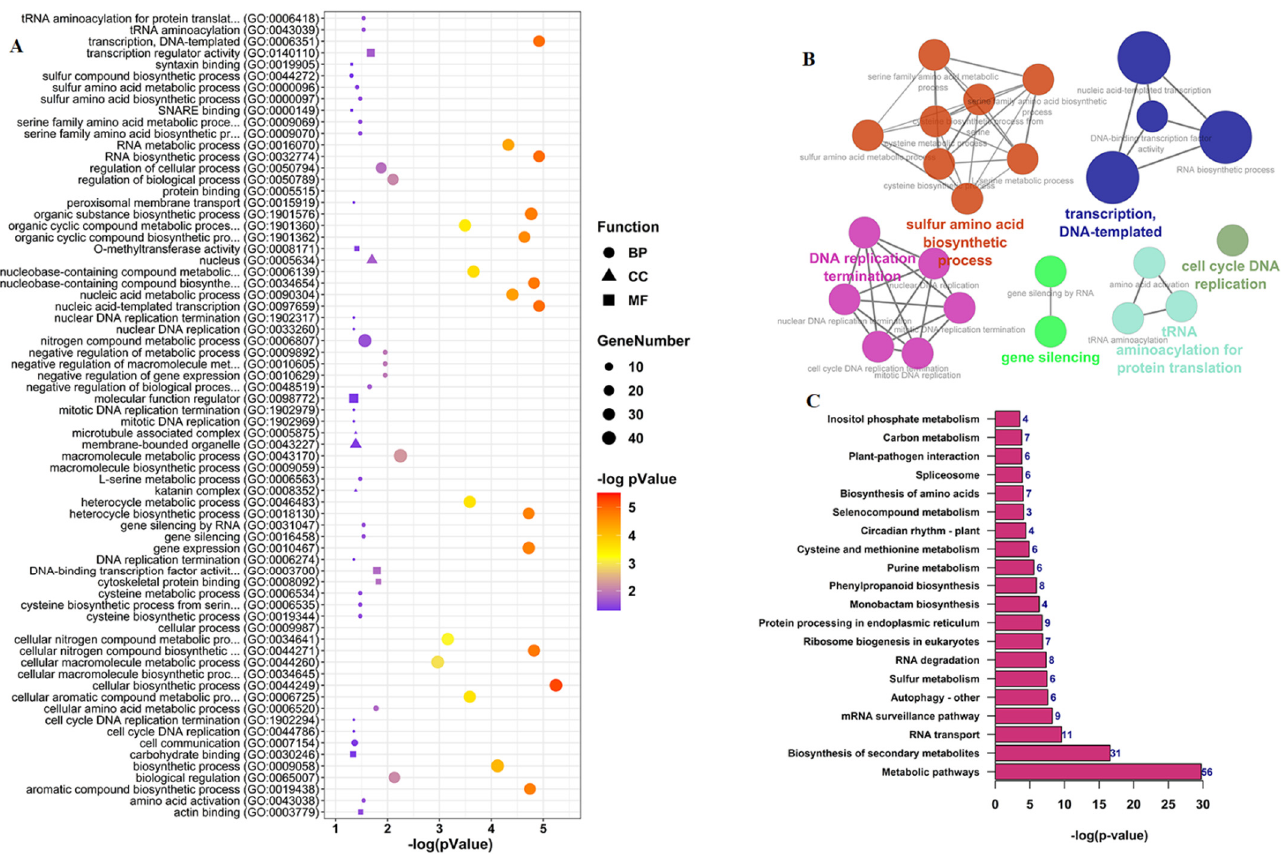
Figure 7. Functional analysis of miRNA target genes during B. rapa pollen development. ( A ) GO enrichment analysis. ( B ) ClueGO network visualizing the most significant GO terms—colors represent GO groups. ( C ) KEGG enrichment analysis. The number on the bars represent the number of genes enriched in the corresponding pathways.